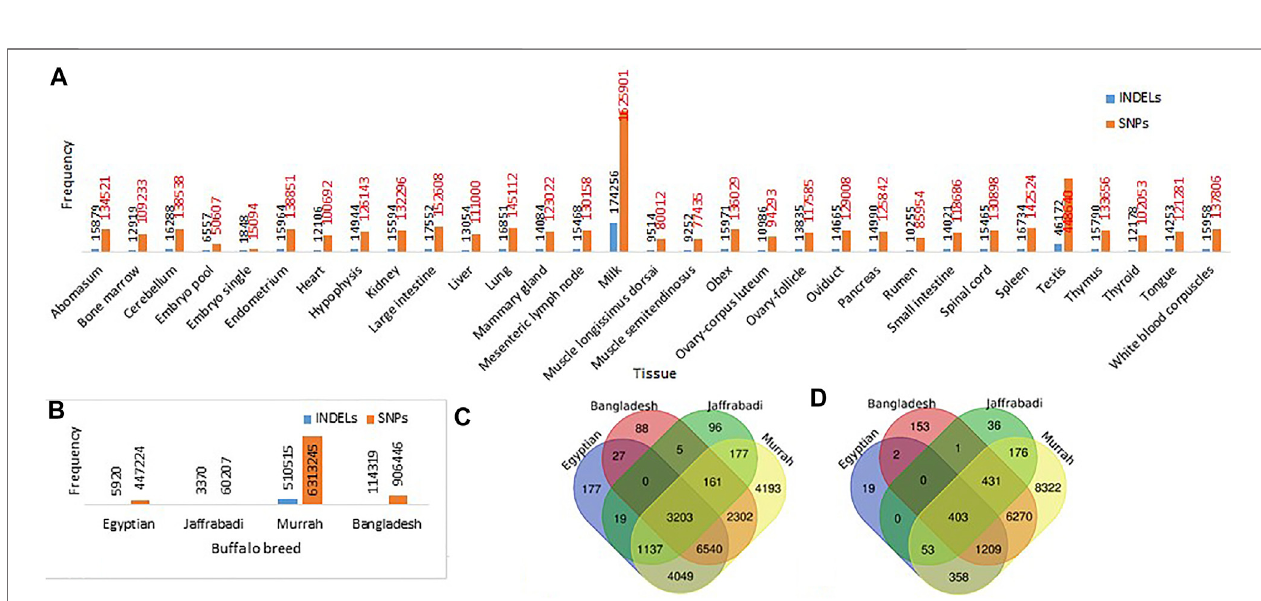
FIGURE 2 | Frequencies of SNP/InDels in (A) 31 different buffalo tissues (B) different breeds of buffalo: Common and unique genes with abundance of (C) SNPs and (D) InDels in different breeds of buffalo.